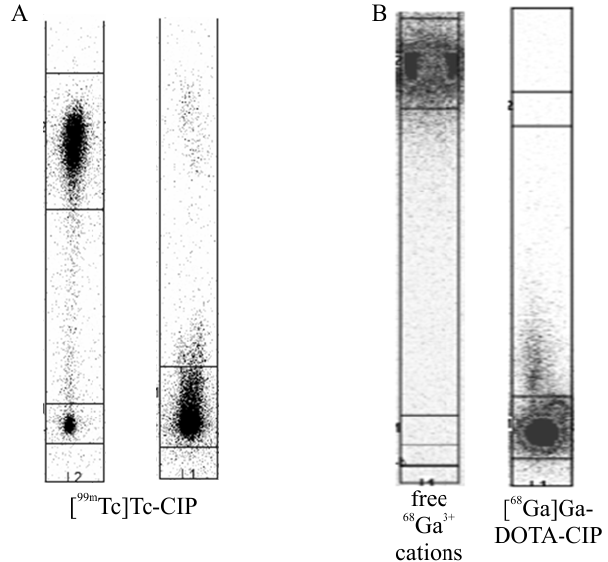
Figure 3. iTLC analyses of reaction mixtures after synthesis of ( A ): [ 99m Tc]Tc-CIP in H 2 O/acetone/NH 3 ( left ) and in acetone ( right ), and ( B ): [ 68 Ga]Ga-DOTA-CIP radioconjugate and free 68 Ga 3+ in citrate buffer.